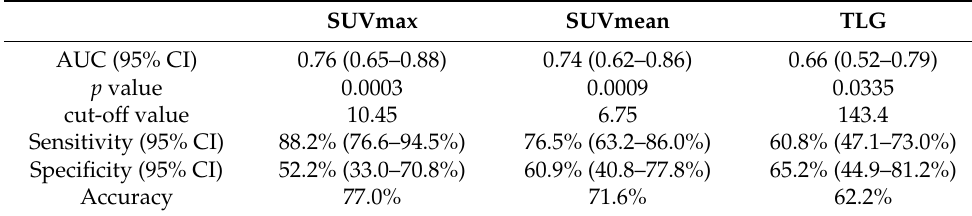
Table 3. ROC curve analysis of the predicting role of PD-L1 status by metabolic parameters.